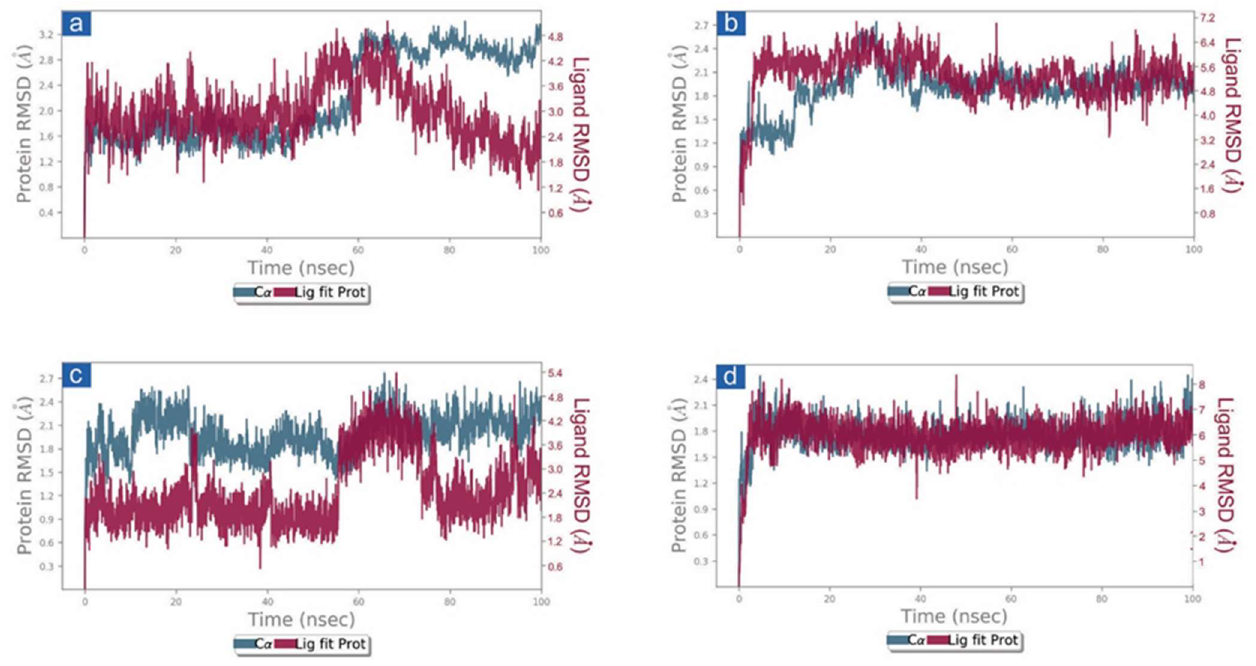
Figure 3. RMSD plots for SARS-CoV-2 M pro docked with potential compounds, i.e., ( a ) Cassameridine, ( b ) Laetanine, ( c ) Litseferine, and ( d ) Cassythicine, extracted from 100 ns MD simulation.